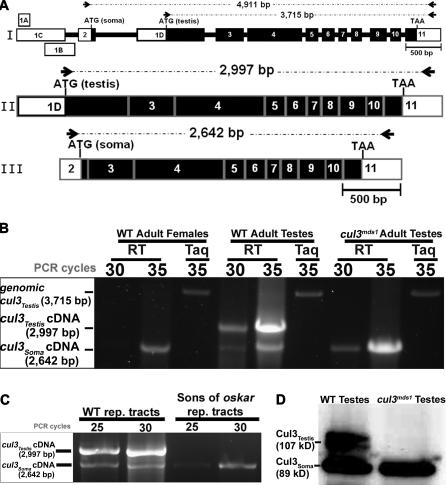
The Expression of cul3Testis Is Restricted to Male Germ Cells(A) Schematic structures of the Drosophila cullin-3 gene (I) and of cul3Testis (II) and cul3Soma (III) mRNAs. Exons and introns are indicated by thick and thin bars, respectively. Thick black bars indicate coding sequences, whereas open bars indicate UTRs. The locations of the primers used in the comparative RT–PCR experiments in (B and C) are indicated by arrows, and the expected length sizes of the amplified fragments are indicated above each scheme.(B) Analysis of cul3Testis versus cul3Soma expression in the testis and the soma. The above primers (arrows in A) to amplify either a 2,997-bp cul3Testis or a 2,642-bp cul3Soma cDNA fragment were added to one reaction master-mix. The reaction was stopped at different cycle points to identify the linear amplification phase (30 and 35 cycles are indicated). The “RT” columns represent reverse transcriptase followed by PCR reactions, and the “Taq” are the control, PCR-only, reactions. Note that the cul3Testis expression levels were much higher in the wild-type (WT) testes than these of cul3Soma. On the other hand, only cul3Soma transcripts were detected in somatic tissues, which are represented by adult female flies. In addition, no cul3Testis transcripts were detected in cul3mds1 mutant testes, confirming that this is a null cul3Testis allele.(C) The expression of cul3Testis is restricted to the male germ cells. While the expression of cul3Soma was not affected in sons of oskar agametic testes, no cul3Testis expression was detected.(D) Consistent with the RT-PCR analysis, no Cul3Testis protein was detected in cul3mds1 mutant testes on Western blot. Note, however, that expression of the Cul3Soma protein in cul3mds1 mutant testes was unaffected.